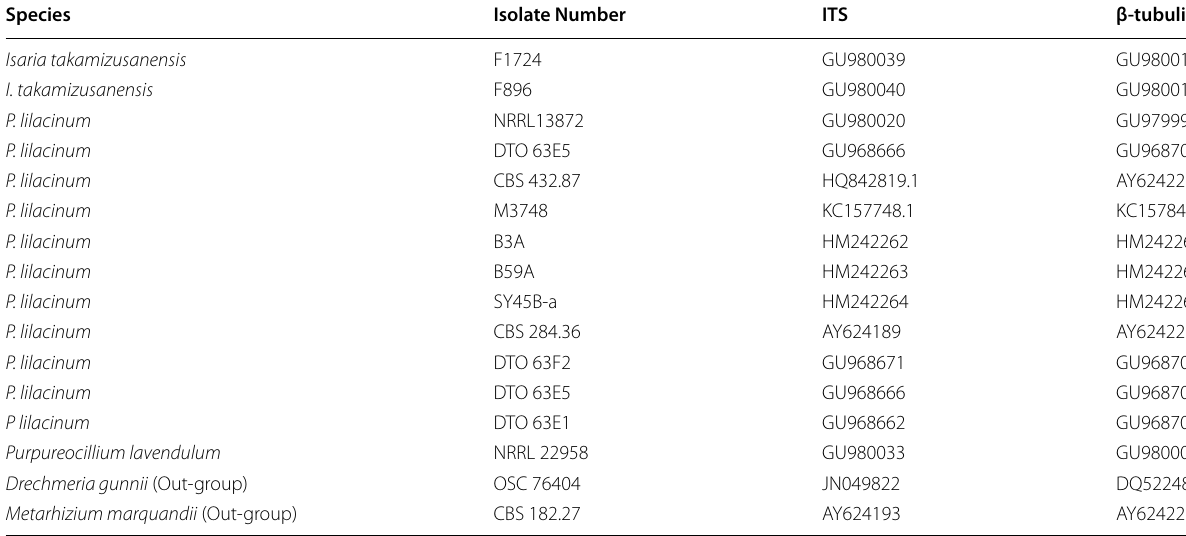
Table 2 Species, isolates and accession numbers included in the study Species